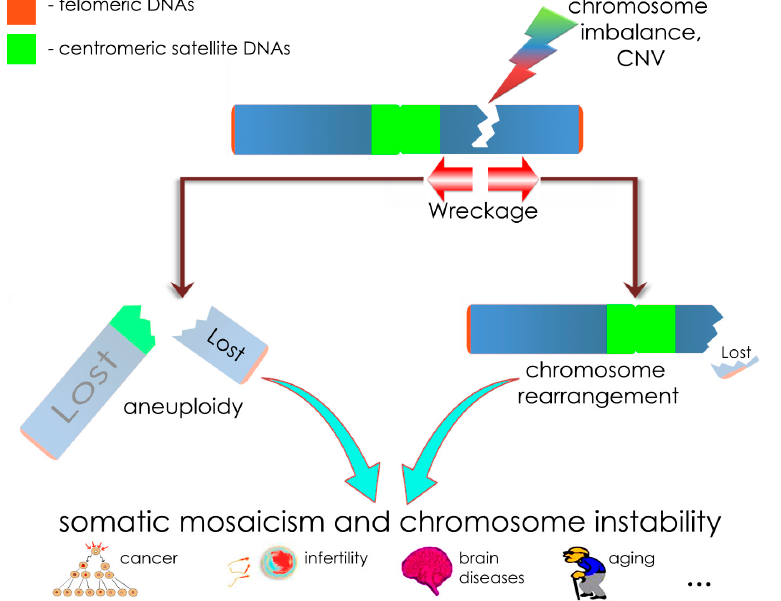
Figure 3. Schematic depiction of chromohelkosis due to a deletion and suggested outcomes relevant to the cytogenomic “theory of everything” (discussed hereafter). Chromosomal imbalances or CNV manifesting as deletions are able to cause instability at the sequence level (GIN) at the breakpoints. Consequently, wreckage may occur through altered DNA damage response and reparation, which cause progressive loss of chromosomal DNA localized at the breakpoints. According to the theory, (centromeric) satellite DNA protects chromosomes from propagation of chromohelkosis in the same way as telomeres do. However, the protection may fail to initiate two scenarios: (i) the distal chromosome part is wrecked and lost, when telomeres are affected; as a result, somatic chromosome rearrangements are formed (on the right-hand side); (ii) the proximal chromosome part is wrecked and, if centromeric satellite DNA fails to protect the centromere, the whole chromosome is lost (i.e., aneuploidy/monosomy) (on the left-hand side). This cascade of CIN/GIN processes results in somatic mosaicism and CIN, which are mechanisms for cancer, infertility, brain diseases, aging, and, probably, other morbid conditions. To depict a biological basis of chromohelkosis, we have used parts of figures from our previous articles distributed under the terms of the Creative Commons Attribution License